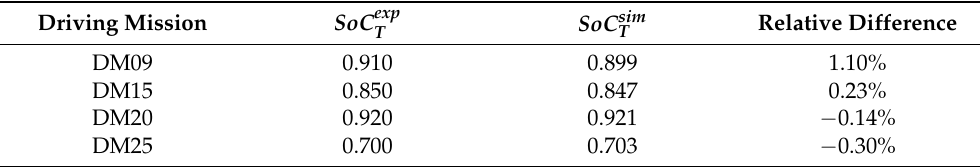
Table 4. Results of the model validation on DM09, DM15, DM20 and DM25 based on the final values of the battery state of